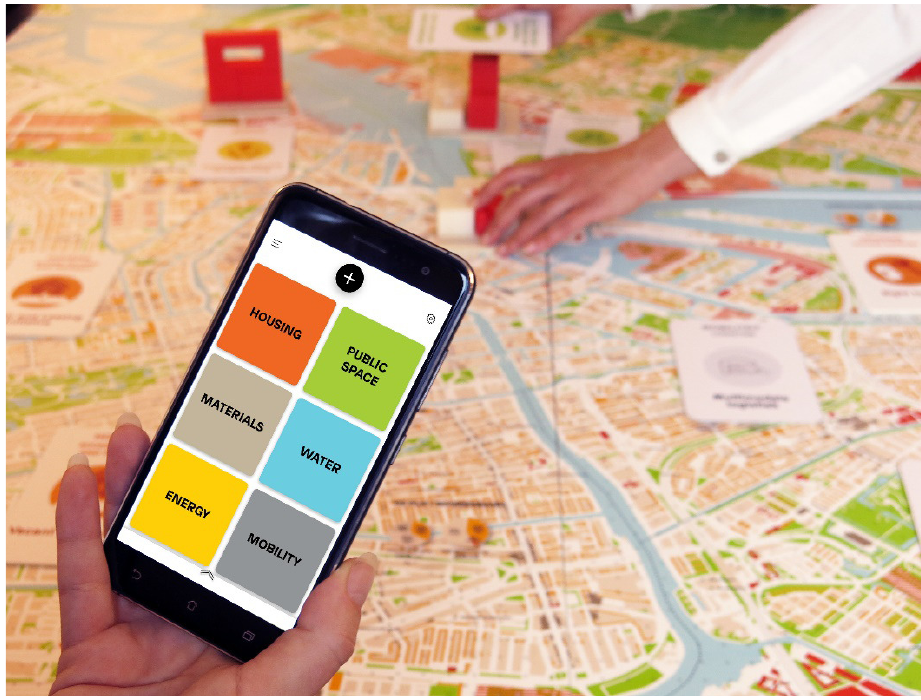
Figure 7. A shot from the NoG